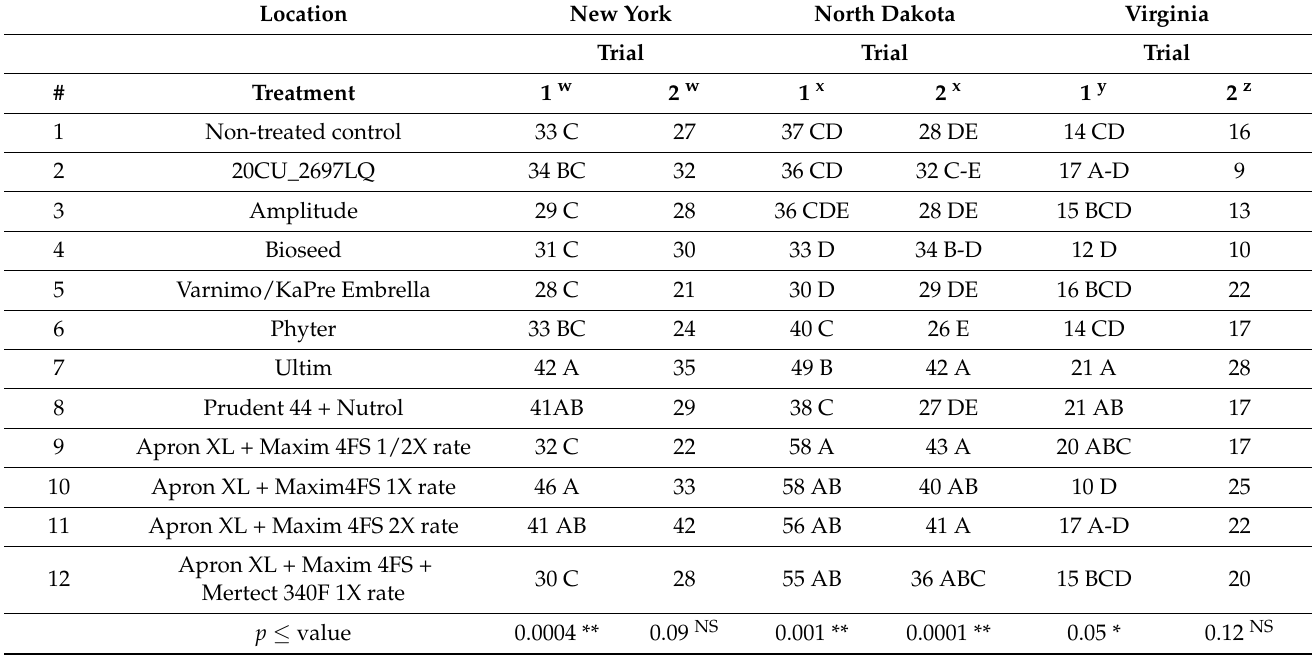
Table 5. Final stand counts (% emerged seedlings/plants) in two trials of hemp seed treatments across three locations in